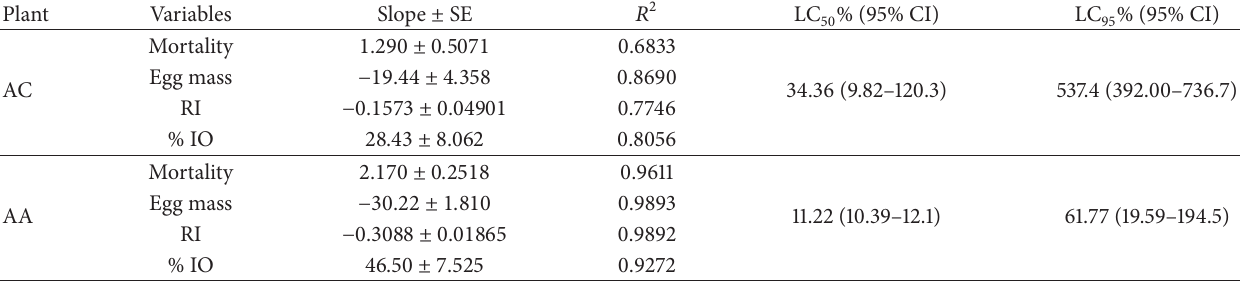
Table 3: Dose-dependent response of A. conyzoides (AC) and A. absinthium (AA) against R. microplus using AIT.